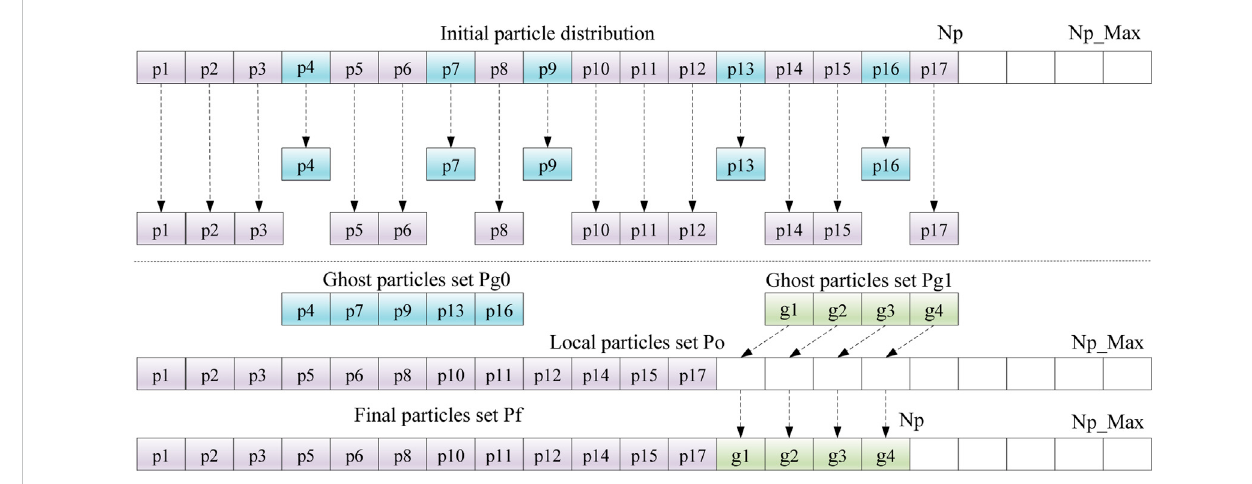
FIGURE 6 The entire procedure of parallelizing the particle update module.